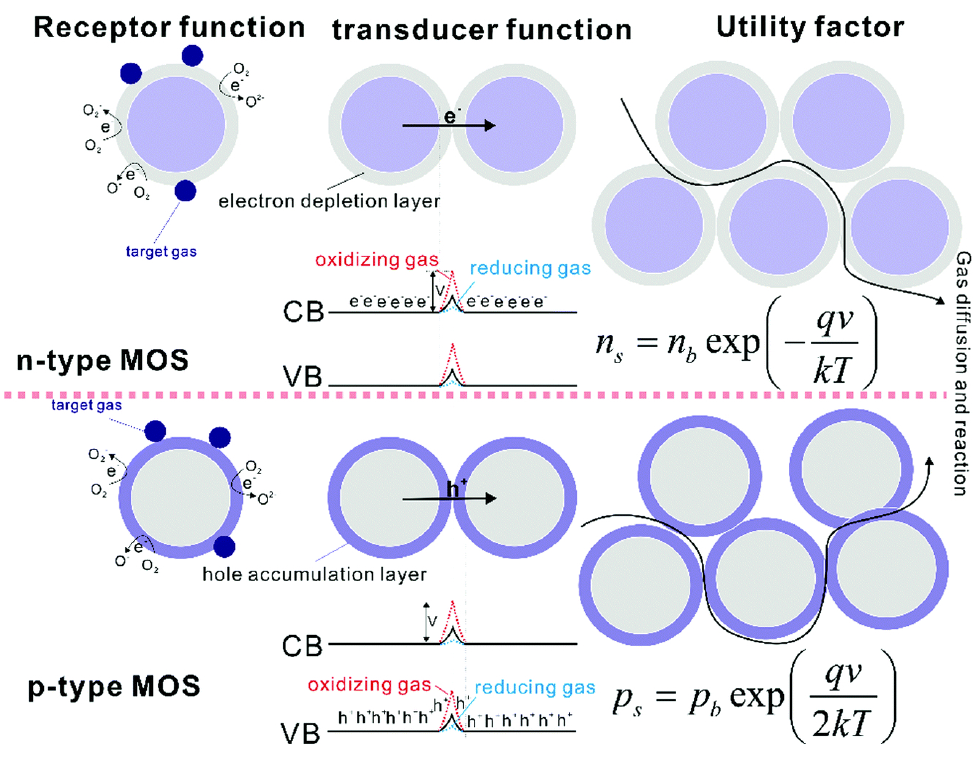
Figure 3. The n-type and p-type MOS-based gas-sensing method and conduction model. [Reprinted with permission from ref. [32]].